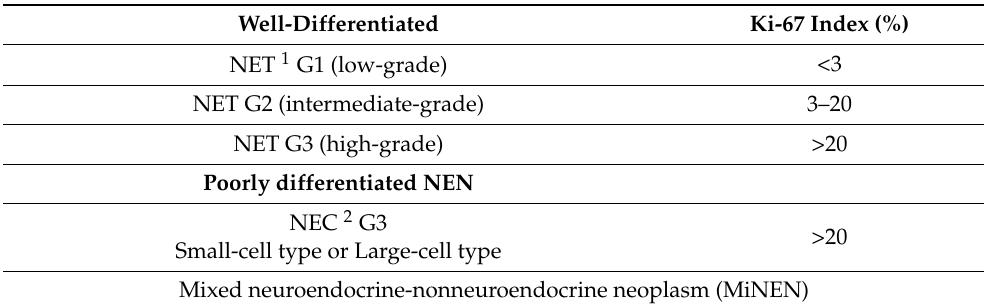
Table 1. The 2019 World Health Organization (WHO) classification for neuroendocrine neoplasms (NEN) of the digestive